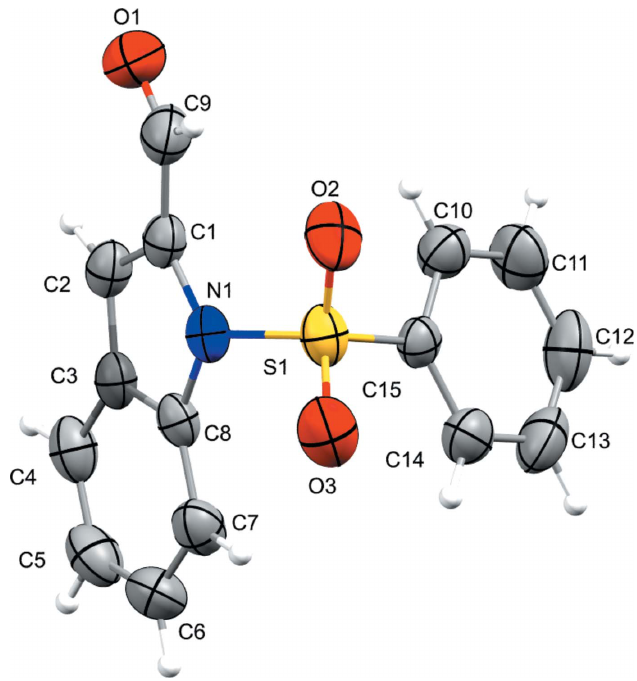
Figure 1 Molecular structure of the title compound with displacement ellipsoids drawn at the 50% probability